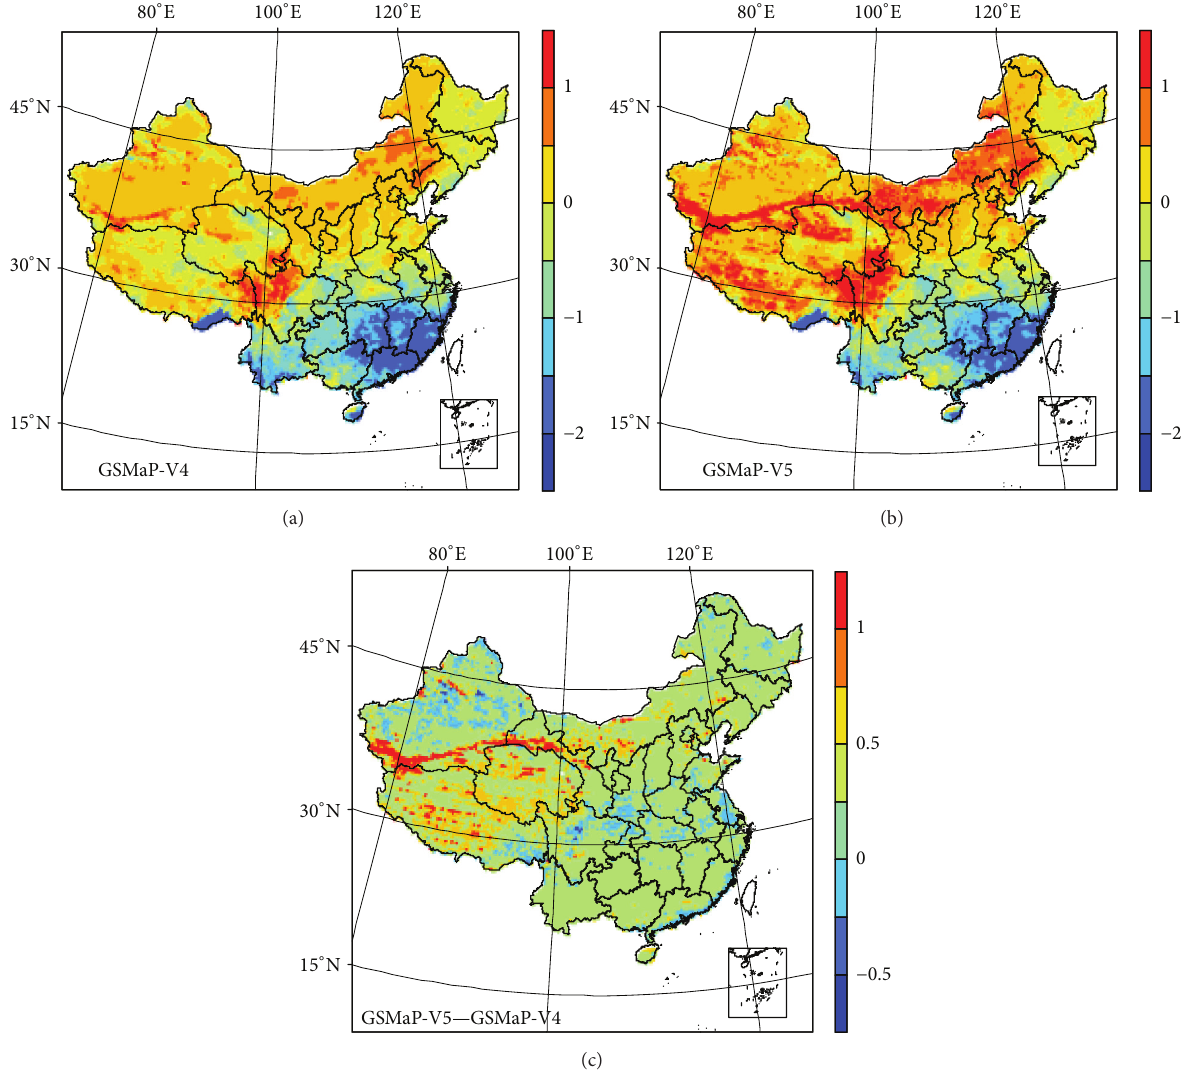
Figure 4: Distribution of mean errors for GSMaP products over the Chinese Mainland from 2003 to 2006. Units are mm/day. (a) GSMaP-V4, (b) GSMaP-V5, and (c) difference between GSMaP-V4 and GSMaP-V5.